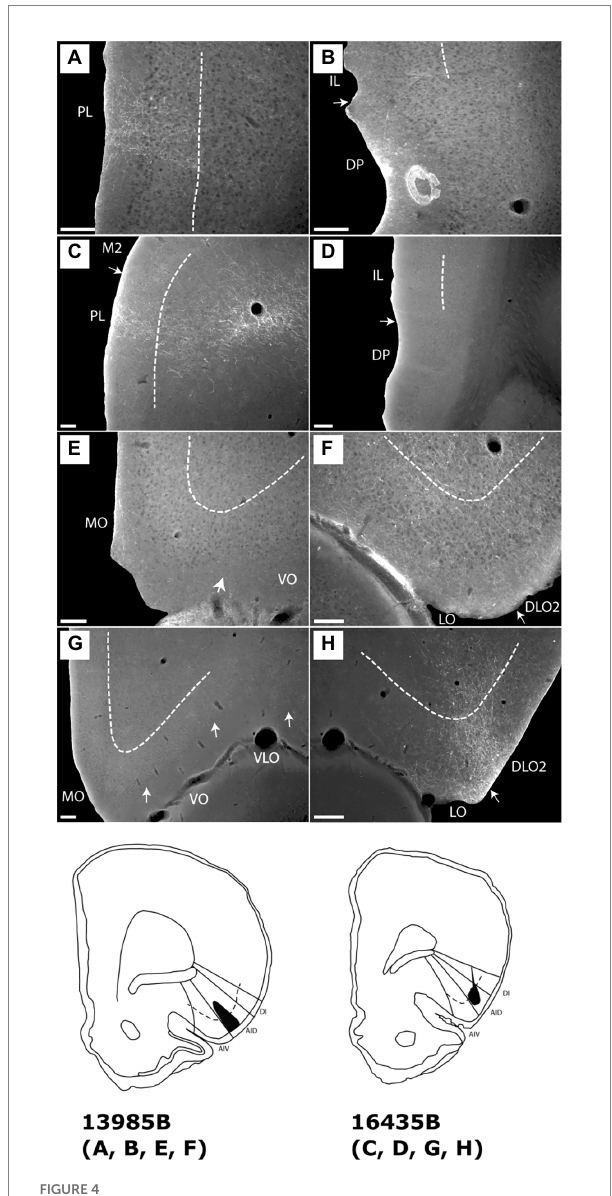
FIGURE 4 Images showing the fiber distribution in medial prefrontal and orbitofrontal cortex following BDA injections into the dorsal agranular insular field (AID) in the anterior insular domain. Two cases with the injection sites are shown in schematics below the images. (A) A dense, but rather confined, fiber plexus is present in superficial layers of the dorsal prelimbic cortex (PL), specifically rostrally, whereas no, or only very limited, fiber labeling is present in other medial prefrontal regions, except for weak labeling in the dorsal peduncular cortex (DP) (case 13985B). (B) In the same case, only very weak labeling is seen in the dorsal peduncular cortex. (C,D) In another case (case 16435B) a similar pattern, as in case 13985B, is seen; dense labeling is present in a rostral portion of the dorsal prelimbic cortex (C) with no, or extremely weak, label in other portions of the medial prefrontal cortex (D) . (E,F) In the orbitofrontal cortex, weak labeling is present in the medial orbital field (MO) (E) with denser labeling in the lateral (LO) and dorsolateral (DLO) orbital fields (case 13985B). (G,H) In case 16435B, dense orbitofrontal labeling is restricted to the lateral and dorsolateral fields. Dashed lines indicate the border between layers 3 and 5. IL, infralimbic cortex; M2, secondary motor cortex; VLO, ventrolateral orbital field; VO, ventral orbital field. Scale bars equal 200 μ